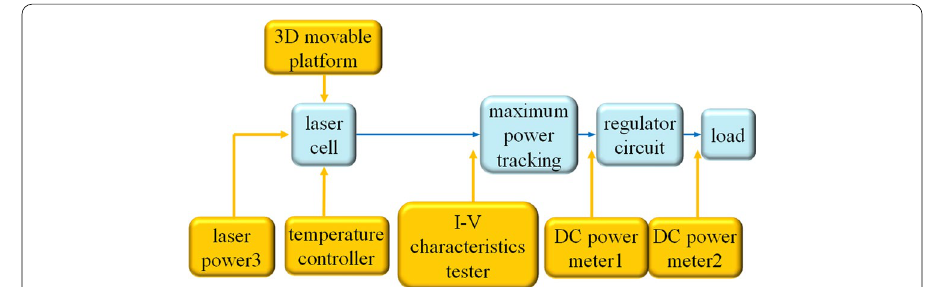
Fig. 5 Receiver side battery component test setup